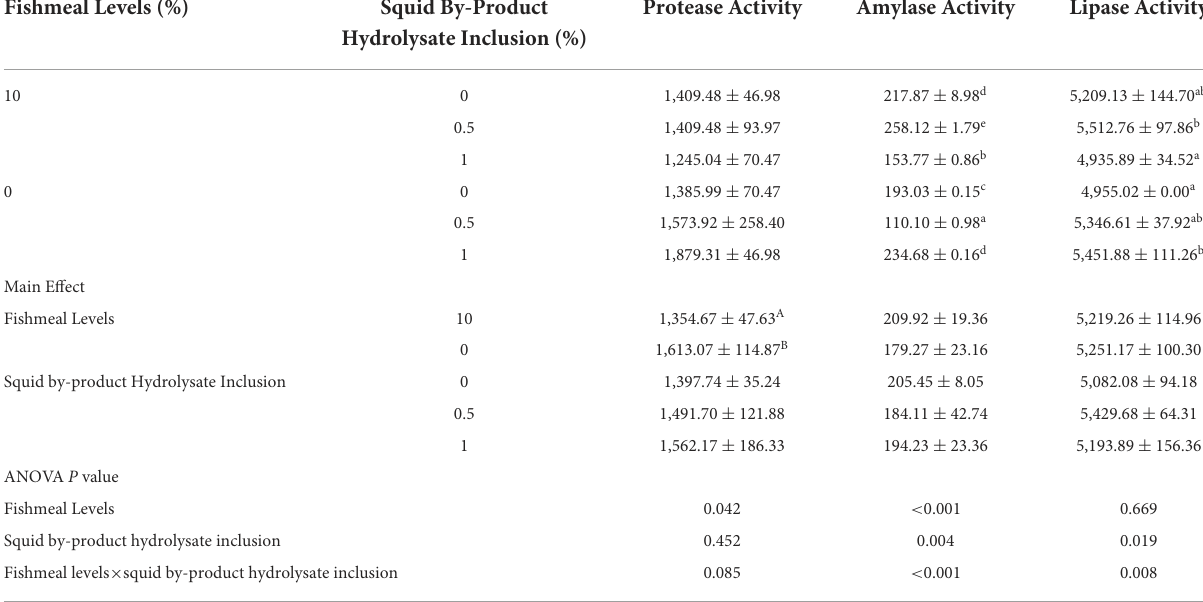
TABLE 8 Digestive enzyme activities of shrimp fed with plant protein-based diets supplemented with squid by-product hydrolysate (units mg − 1 protein). Fishmeal Levels (%) Squid By-Product Protease Activity Amylase Hydrolysate Inclusion (%)